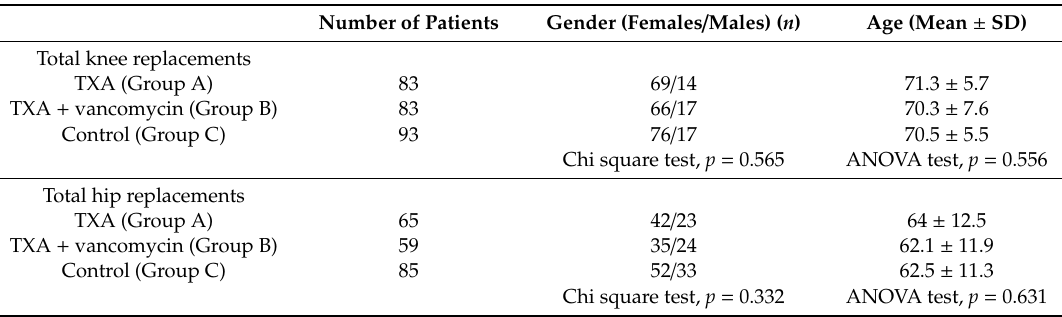
Table 1. Demographics of the